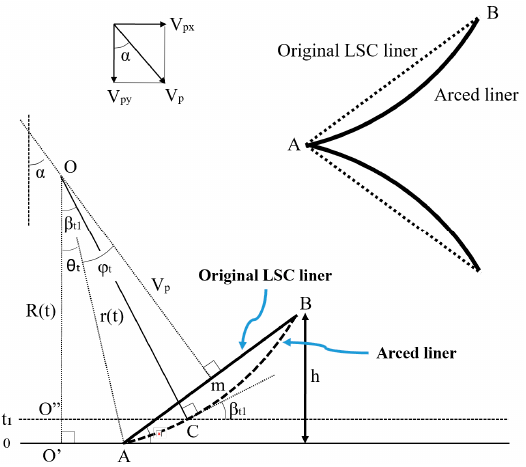
Figure 4. Schematic diagram of arc-deformed LSC liner collapse [12].